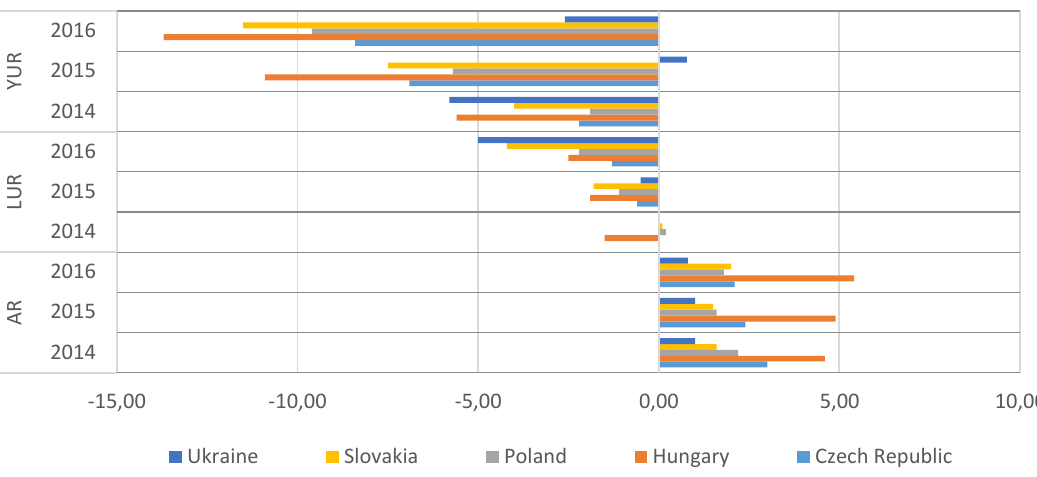
Figure 6. The employment indicators of the macroeconomic imbalance estimation in Ukraine and Visegrad Countries,